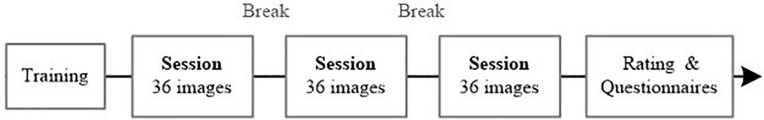
The experimental flow.